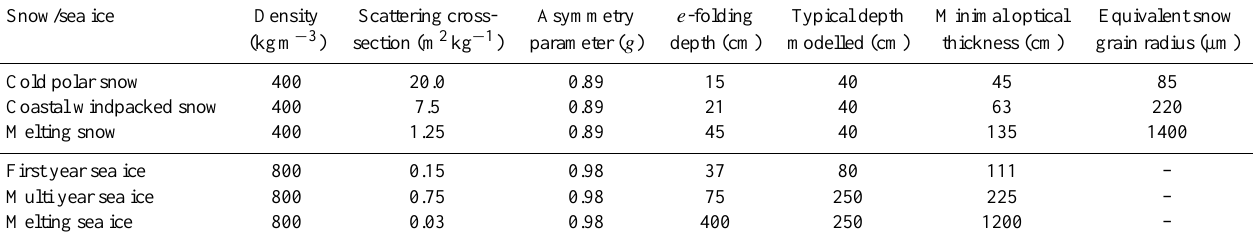
Table 1. Values of the input parameters used for snow and sea ice for the TUV-snow model, based on literature values and detailed in the work of Marks and King (2014).